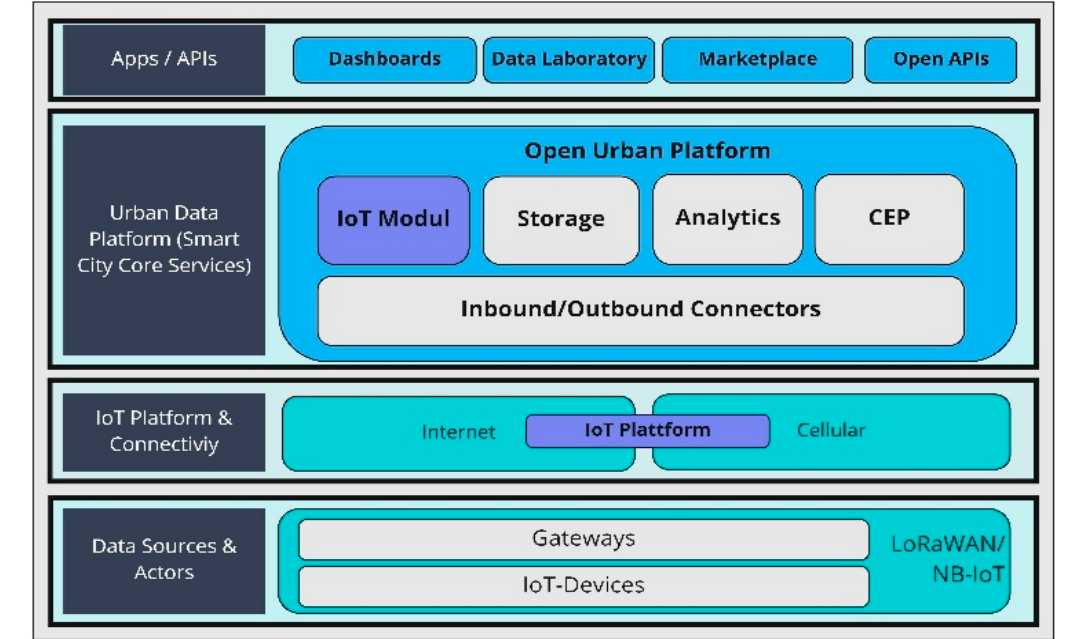
Figure 1. Abstract architecture of an open urban platform.